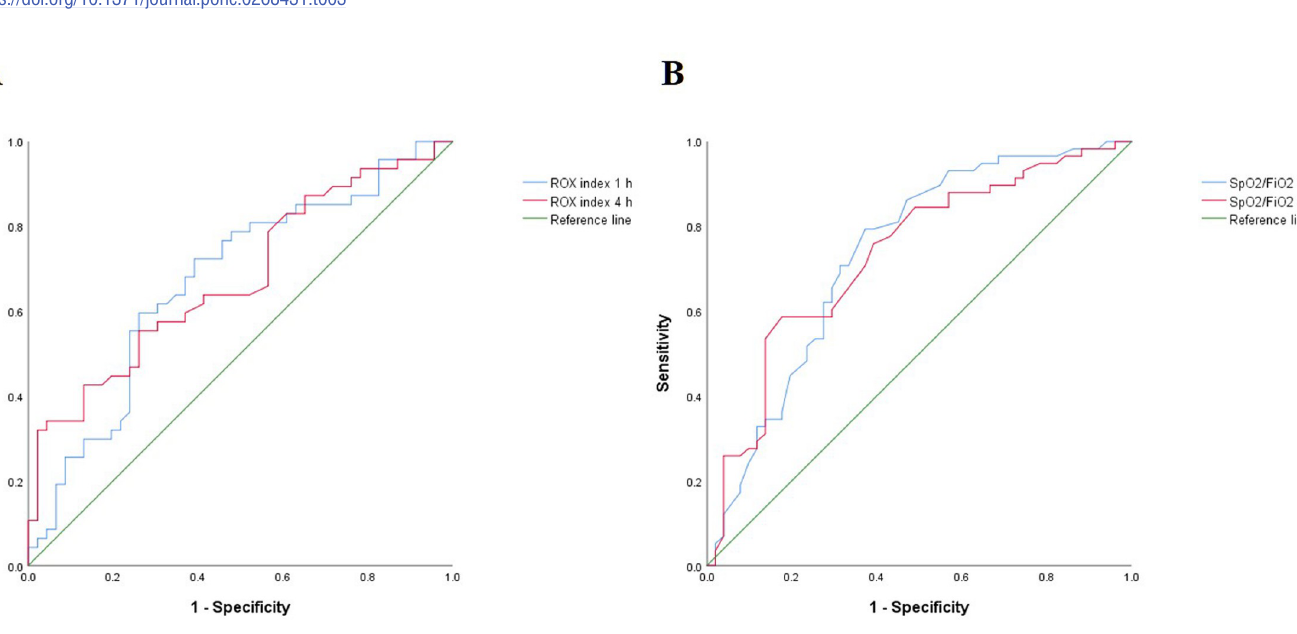
Fig 2. Receiver operator characteristic curves for ROX index and SpO 2 /FiO 2 ratio as predictor of HFNC failure. HFNC, high-flow nasal cannula; ROX, pulse oximetry/fraction of inspired oxygen/respiratory rate; AUROC, area under the receiver operating characteristic curve; CI = confidence interval; SpO 2 , percutaneous oxygen saturation; and FiO 2 , fraction of inspired oxygen. A. AUROC of ROX indices at 1 h and 4 h were 0.697 (95% CI: 0.597–0.798) and 0.682 (95% CI: 0.583–0.781), respectively. B. AUROC of SpO 2 /FiO 2 ratios at 1 h and 4 h were 0.762 (95% CI: 0.679–0.846) and 0.733 (95% CI: 0.640–0.826),